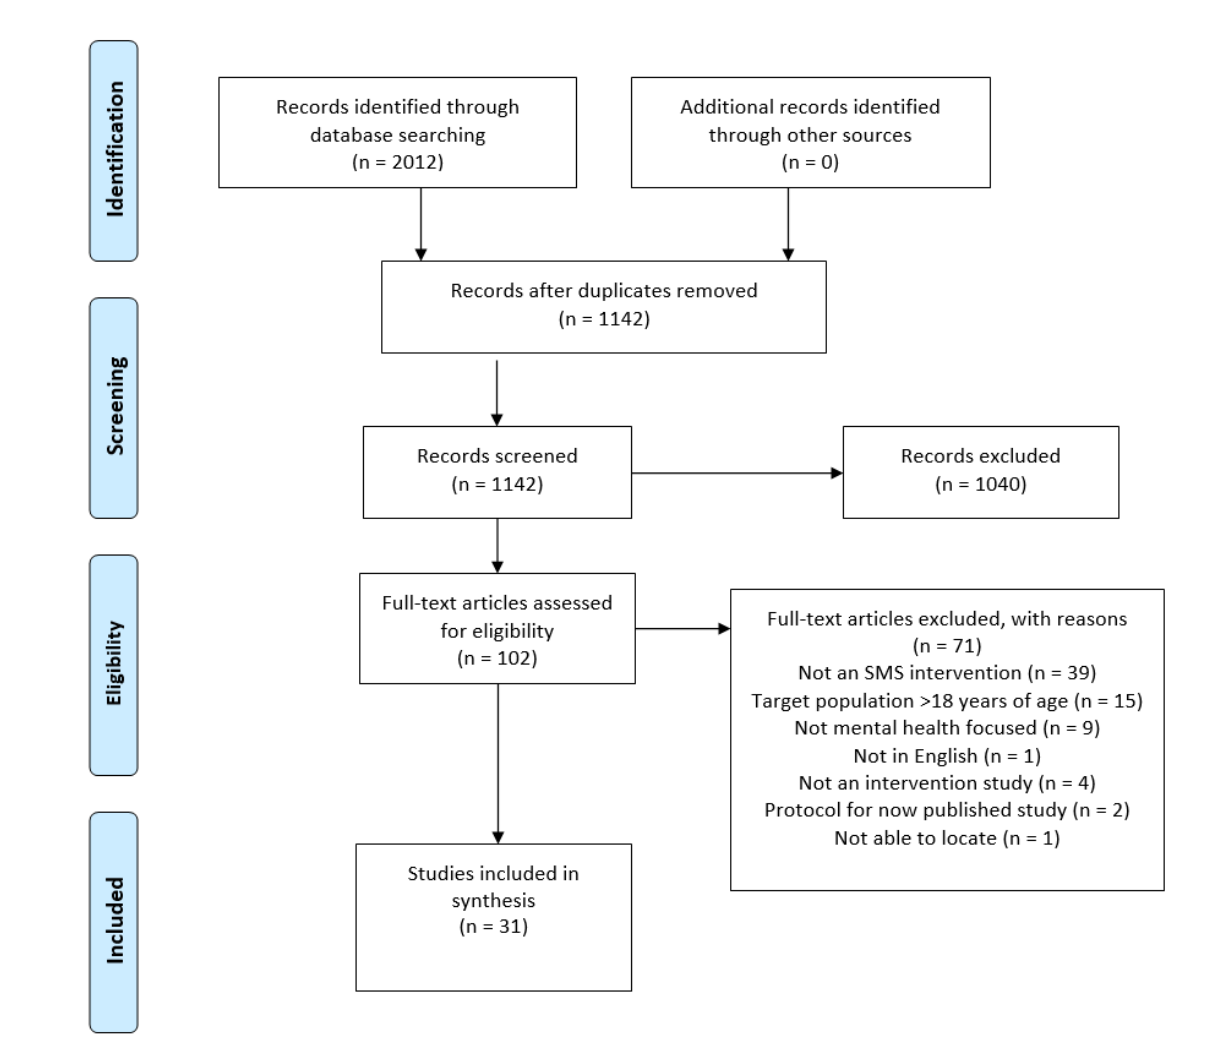
Figure 1. PRISMA flow